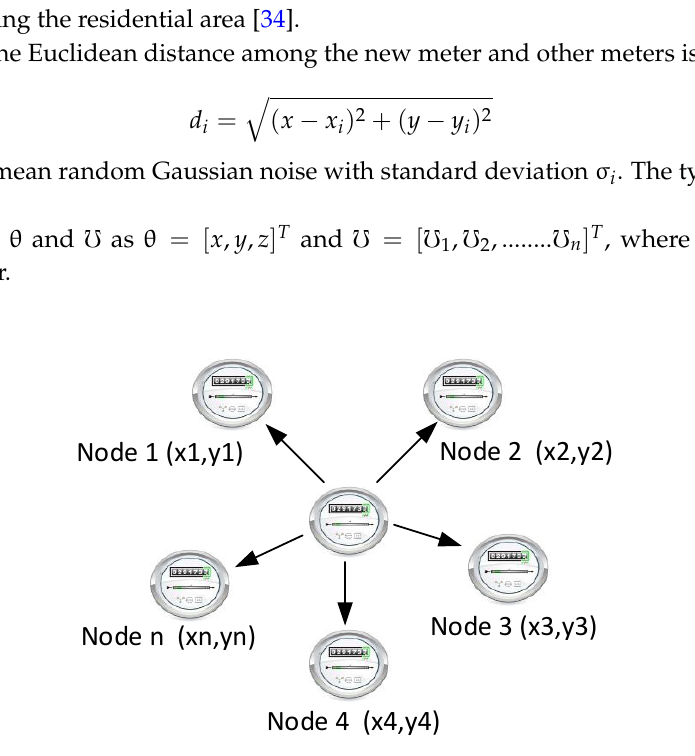
Figure 2. Localization of the new meter (unknown positioned